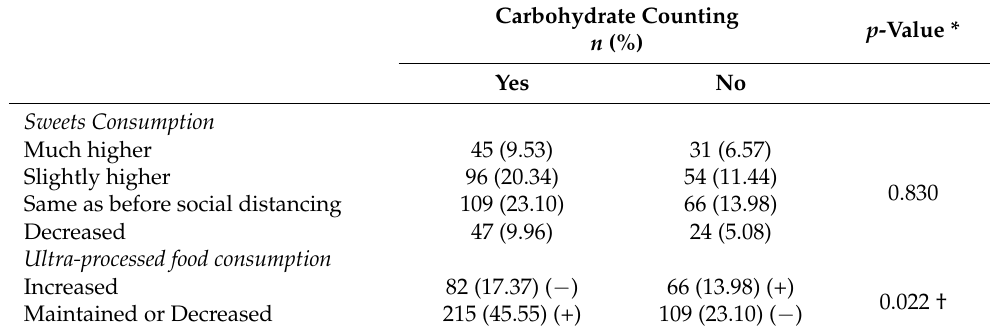
Table 3. Association between CC execution and alimentation of people with T1DM during